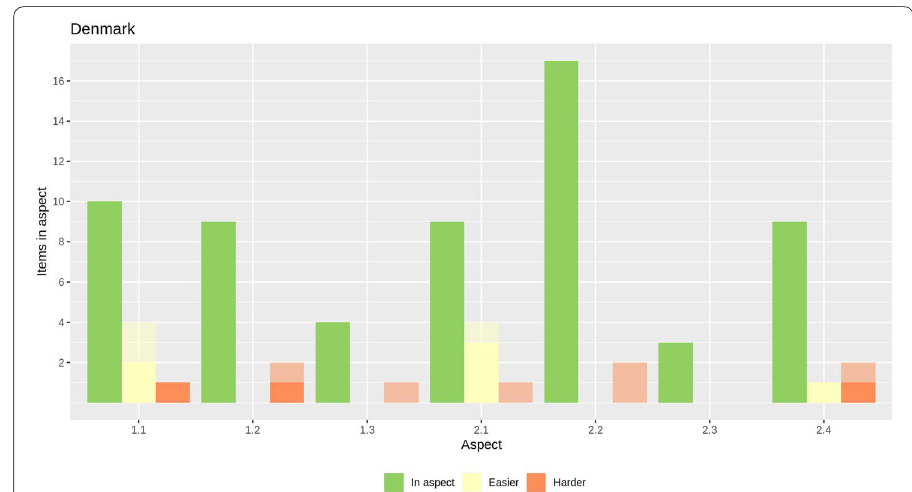
Fig. 1 Items showing DIF for Danish students. Green bars show how many items there are in the aspect in total. Yellow bars show the number of items having a DIF indicating that they are easier for Danish students at level B (darker yellow), level ICILS (medium yellow), and level C (lighter yellow). Orange bars show the number of items being harder for Danish students at levels B, ICILS, and